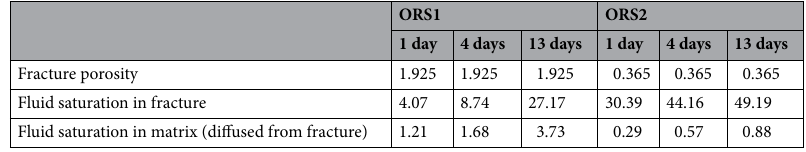
Table 1. Quantitative analysis from 3D segmented